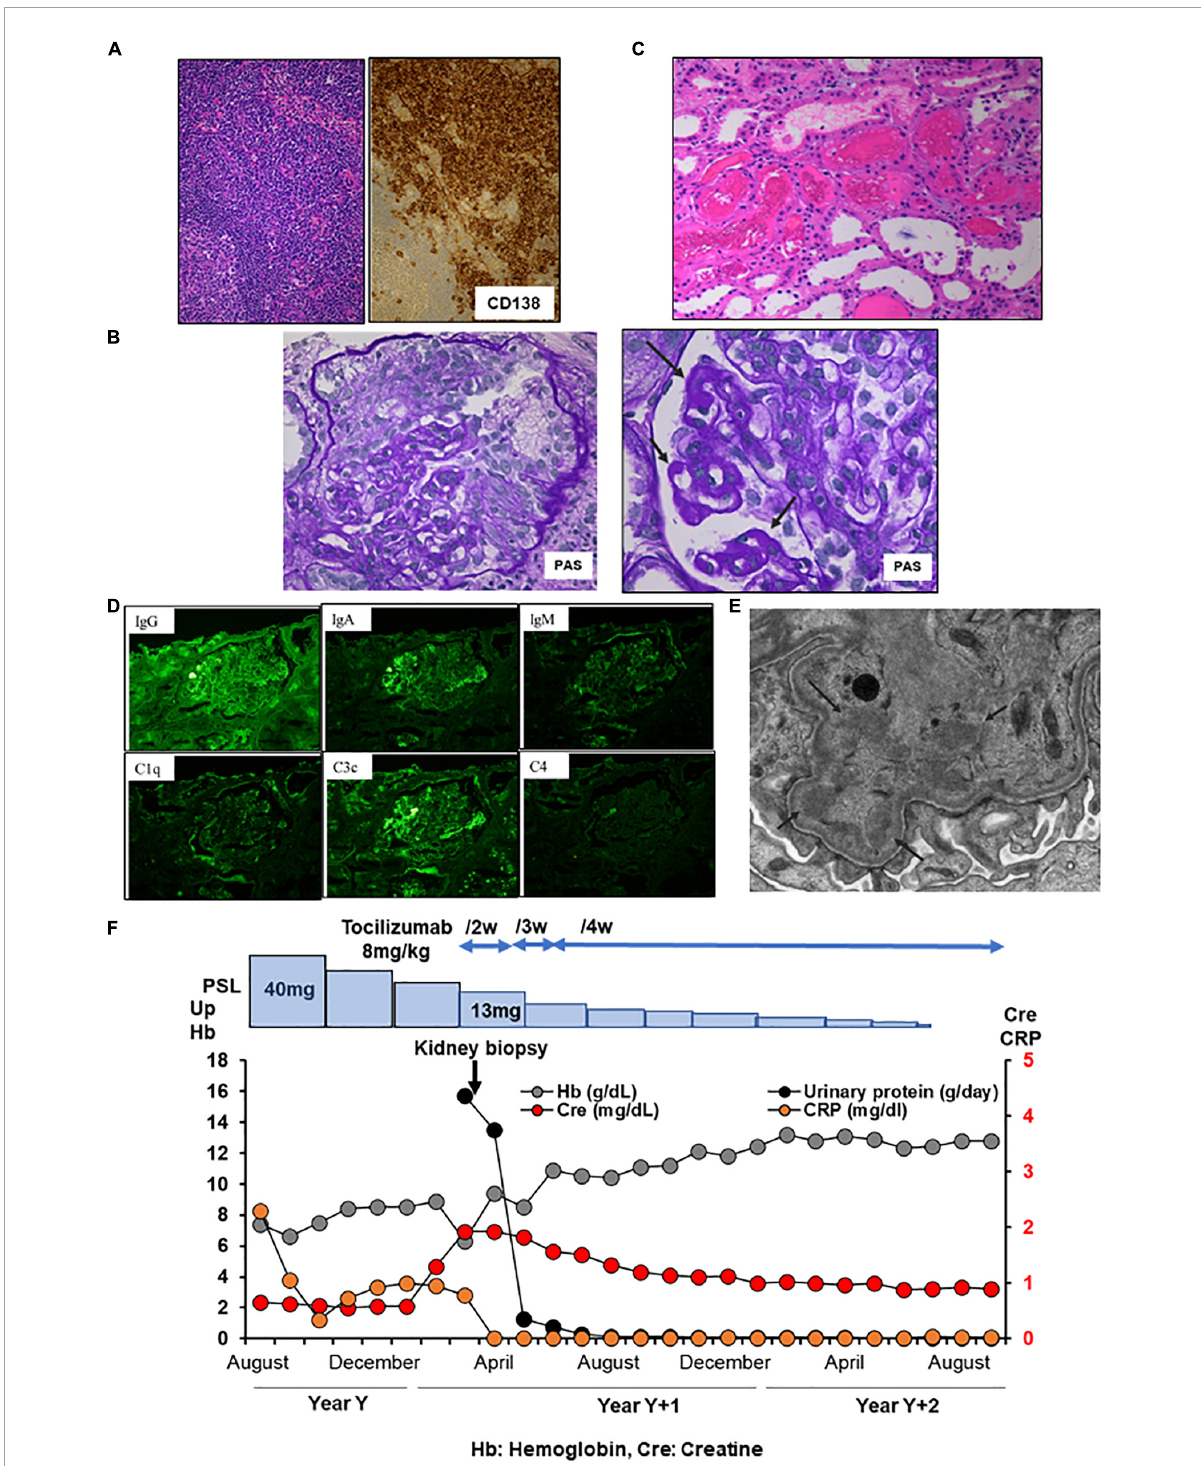
FIGURE2 Histology and time course for Case 2. (A) Light micrograph of the lymph node showing follicular hyperplasia (left lower) and infiltration by plasma cells which are positive for CD 138. (B–E) Renal biopsy. (B) Light micrograph showing focal endo- and extra-capillary hypercellularity with hyaline deposits (arrows). (C) Tubular injury with red blood cell casts is observed. (D) Immunofluorescence micrograph showing granular mesangial and capillary staining for IgG, IgA, IgM, C1q, and C3. (E) Electron micrograph showing mesangial deposits (arrows). PAS: Periodic acid–Schiff. PAM: Periodic acid methenamine. (F) Clinical time course of Case 2. Hb, hemoglobin; Cre, creatine; Up, urinary